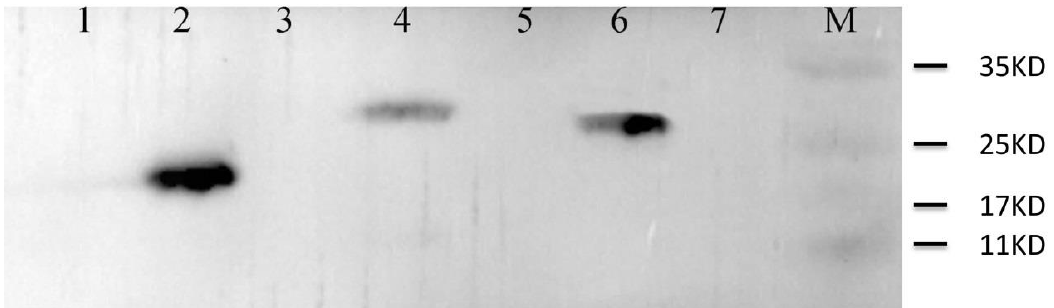
Figure 7. Western blot analysis of SmUSP-overexpression in E. coli BL21. Lanes 1, 3, 5: E. coli BL21 strain harboring pET28a- SmUSP27 , pET28a- SmUSP8 , and pET28a- SmUSP1 without induction, respectively. Lanes 2, 4, 6: E. coli BL21 strain harboring pET28a- SmUSP27 , pET28a- SmUSP8 , and pET28a- SmUSP1 induced for 6 h, respectively. Lane 7: E. coli BL21 strain harboring empty pET28a induced for 6 h. M: marker.